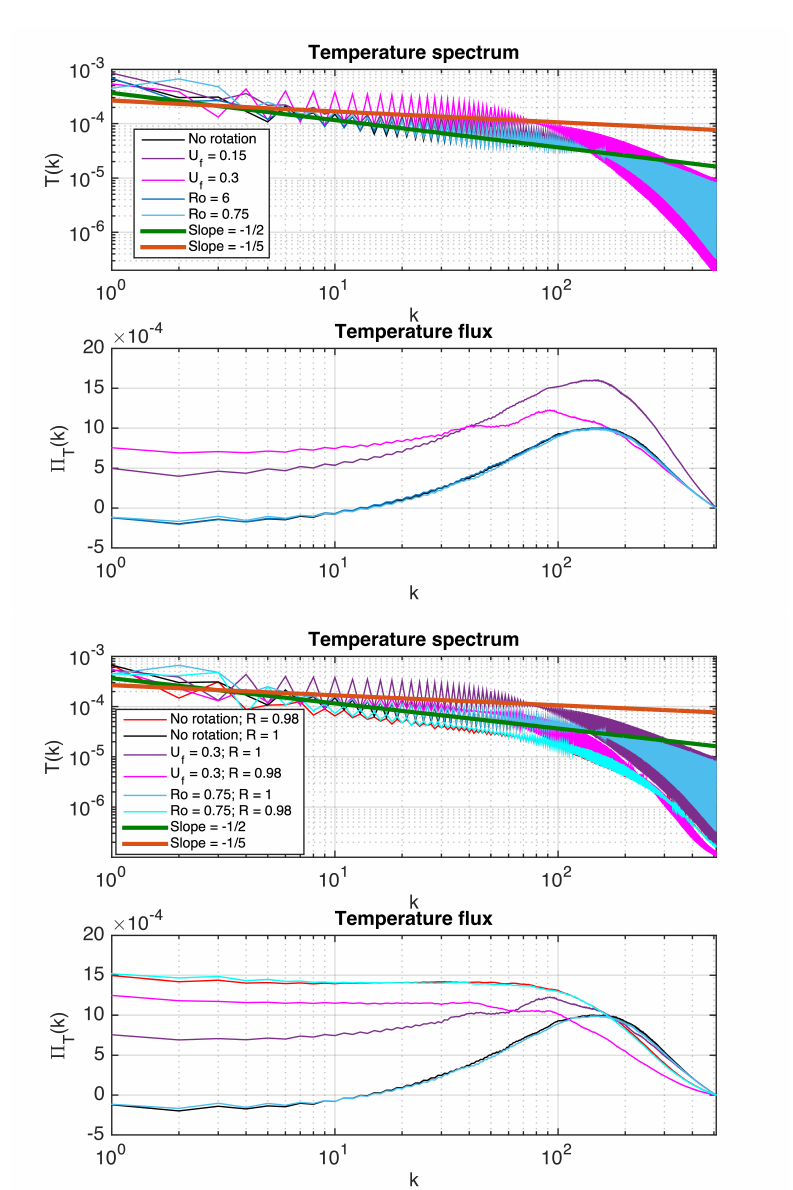
Figure 16. First and second rows: Temperature spectra and fluxes for strong, moderate and no rotation for methods 1 and 2. Third and fourth rows: Tukey windowed temperature spectra and fluxes for strong rotations. Method 1 Ro = 0.75. Method 2 U f = 0.3. Radius of the window R =